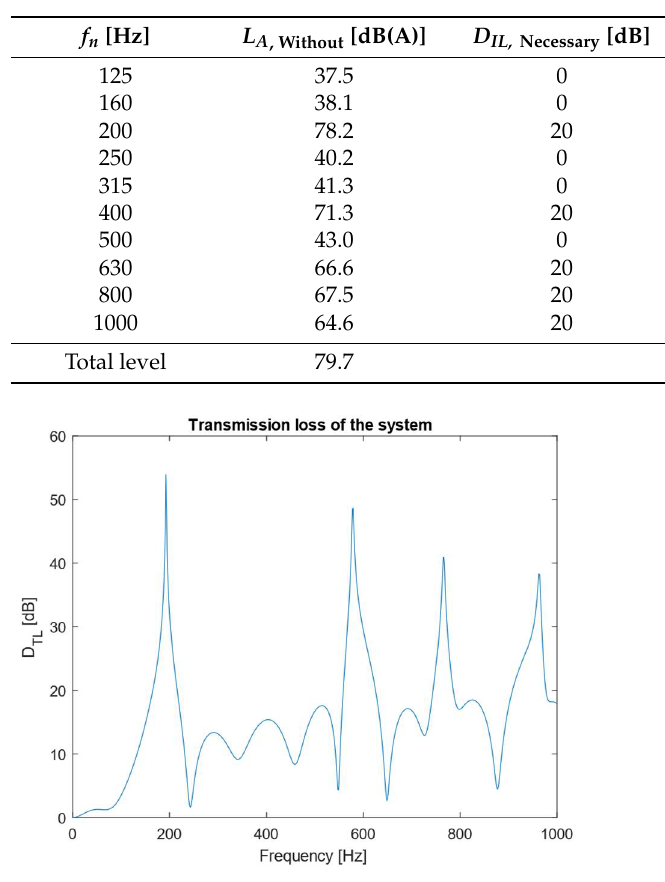
Table 1. Example illustrating how the synthesized third octave band spectrum derived from Figure 11 must be modified to achieve an overall SPL lower than 55 dB(A). The numerical value 20 dB is not a requirement on minimum reduction. It is merely an indicator that reduction measures are needed in that band.